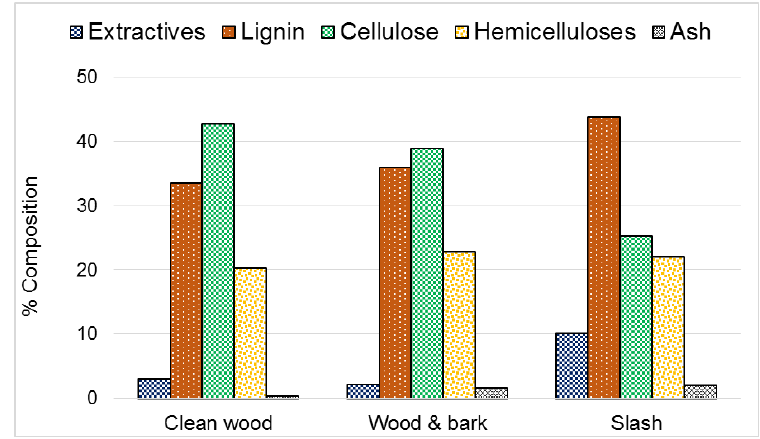
Figure 1. Chemical composition and ash content of forest logging residue.